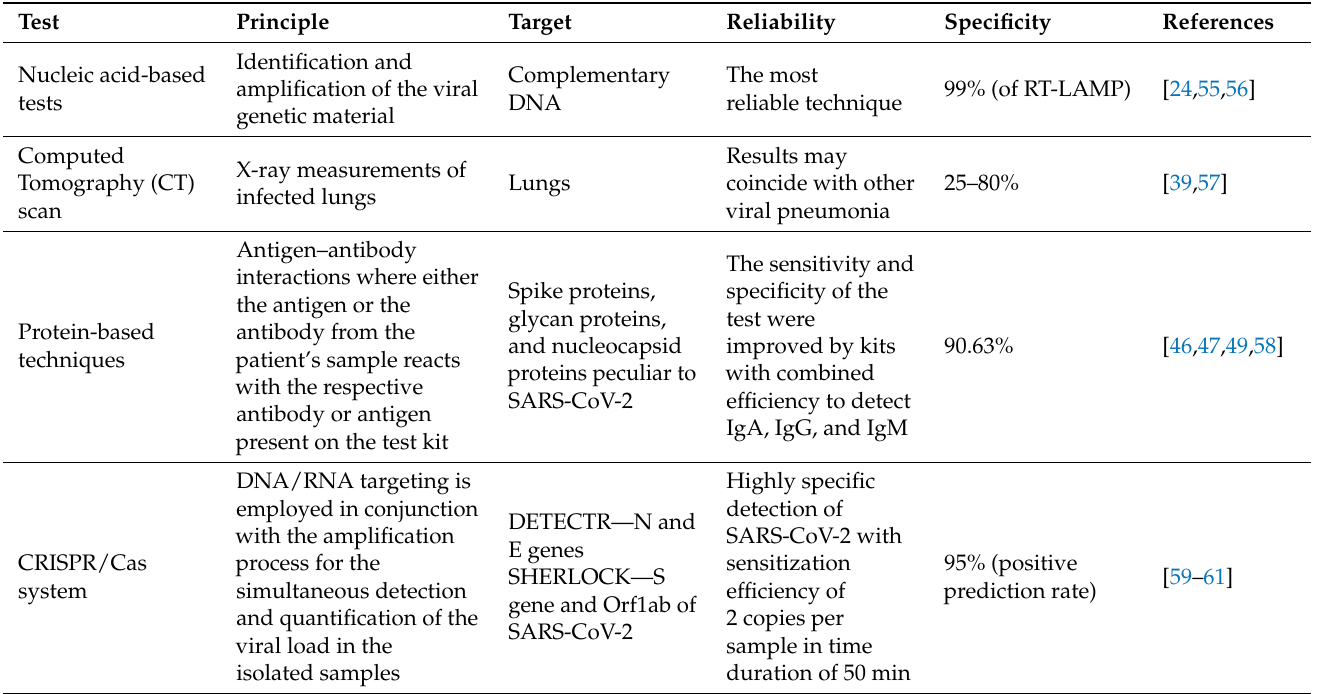
Table 2. Summary of prominent diagnostic techniques for the detection of